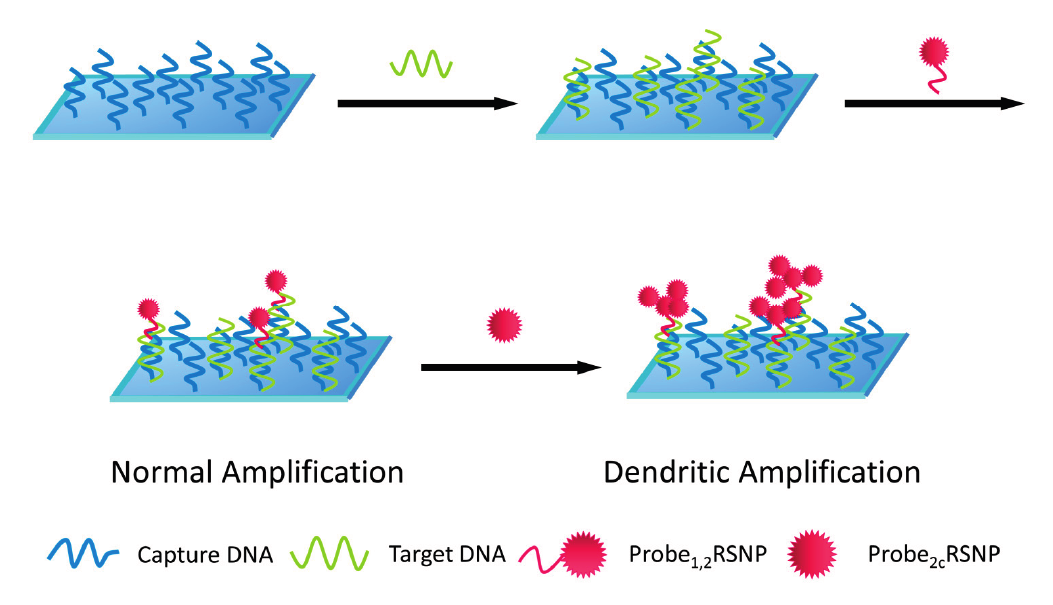
Figure 10. Sandwich DNA detection using dendritic Ru(bpy) 32+ -doped silica nanoparticles for ECL signal amplification. RSNP, Ru(bpy) 32+ -doped silica nanoparticles. Reprinted with permission from ref. [181], copyright (2010) Royal Society of